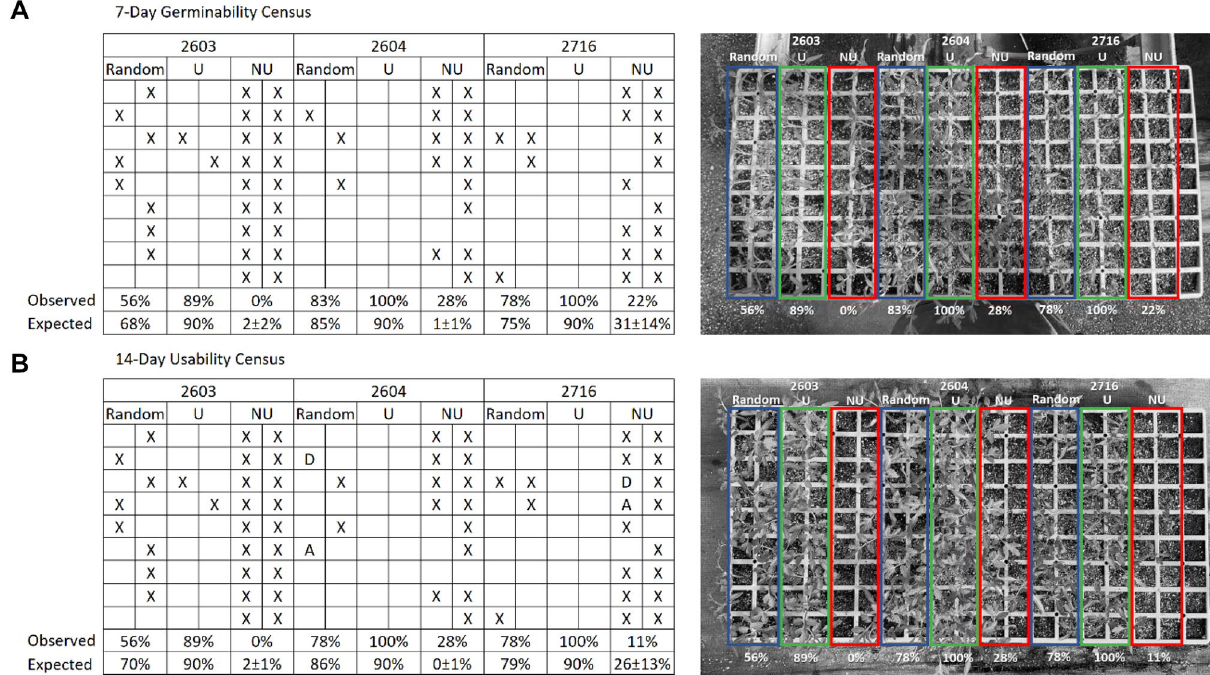
Figure 2. Sorting of three tomato seed lots by usability. Lots 2603, 2604 and 2716, pertaining to three distinct varieties, were sorted by their usability predictions and phenotyped for germinability and usability 7- and 14-days post sowing, respectively. Phenotyping data on the left correspond with the germination status captured on the right. A random selection, reflecting basal germinability or usability rates was compared to putative usable and non-usable portions, each represented by 18 seeds. Observed germinability and usability rates were compared to the expected ones (data taken form Table S1). Differences between the two are likely to result from the low sampling size. Still, germinability and usability were markedly enhanced to the expected rates. Random– random selection (framed in blue rectangle on the right); U-putative usable (framed in green rectangle on the right); NU-putative non-usable (framed in red rectangle on the right); X-non-germinating seed; A-abnormal seedling; D-delayed